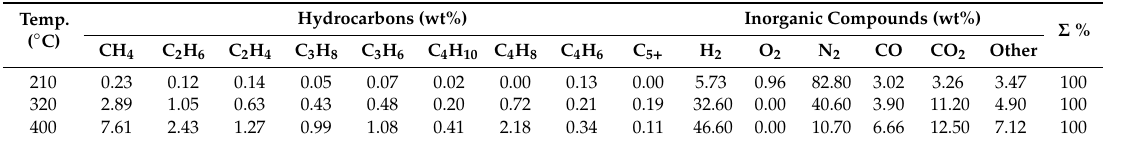
Table 5. Gas composition, postconsumer material, 400 ◦ C.